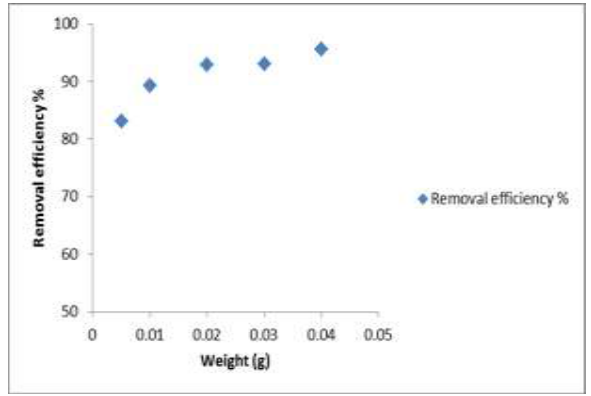
Fig.4: Effect of weight on the removal efficiency .